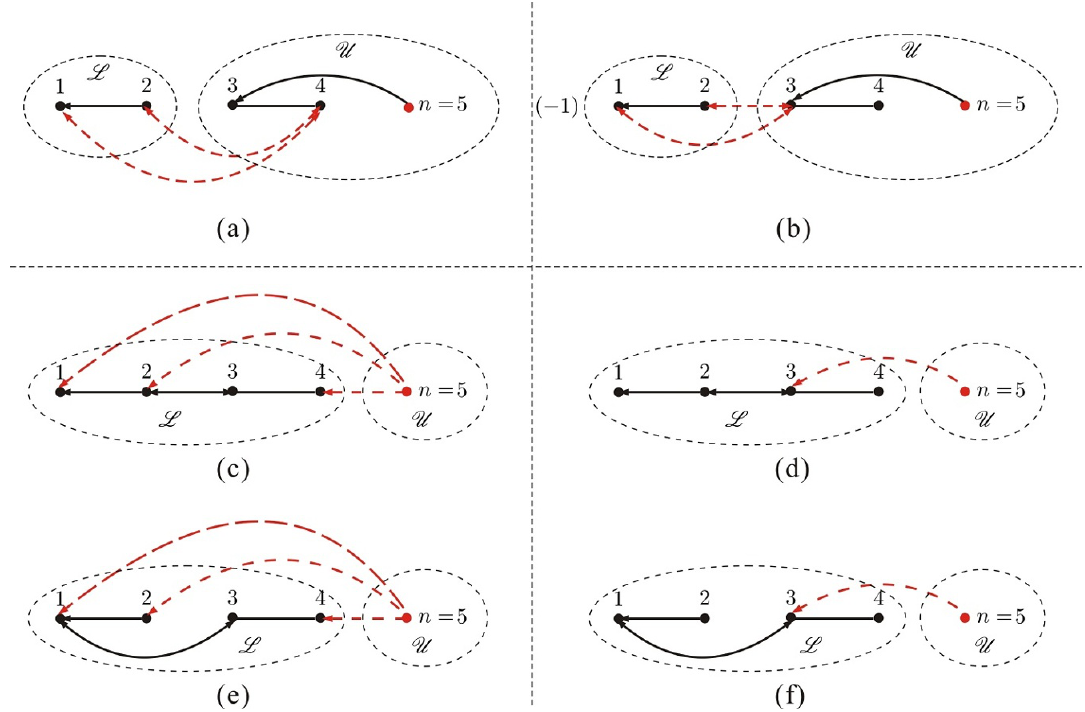
Figure 22 . Graphs (a), (c) and (e) are physical graphs corresponding to the skeleton (cid:12)gure 20 (b). The type-I chain belongs to the (cid:12)nal upper (lower) block in (a)((c)and (e)). Corresponding spurious graphs are given by (b), (d) and (f). The (cid:12)nal upper block in (b) contains a spurious component (i.e. the type-I component), thus there should be an extra minus. In graphs (d) and (f), the (cid:12)nal upper block does not contain any spurious component, thus the sign is plus. All spurious graphs (b), (d) and (f) cancel out (noting that (b) stands for two